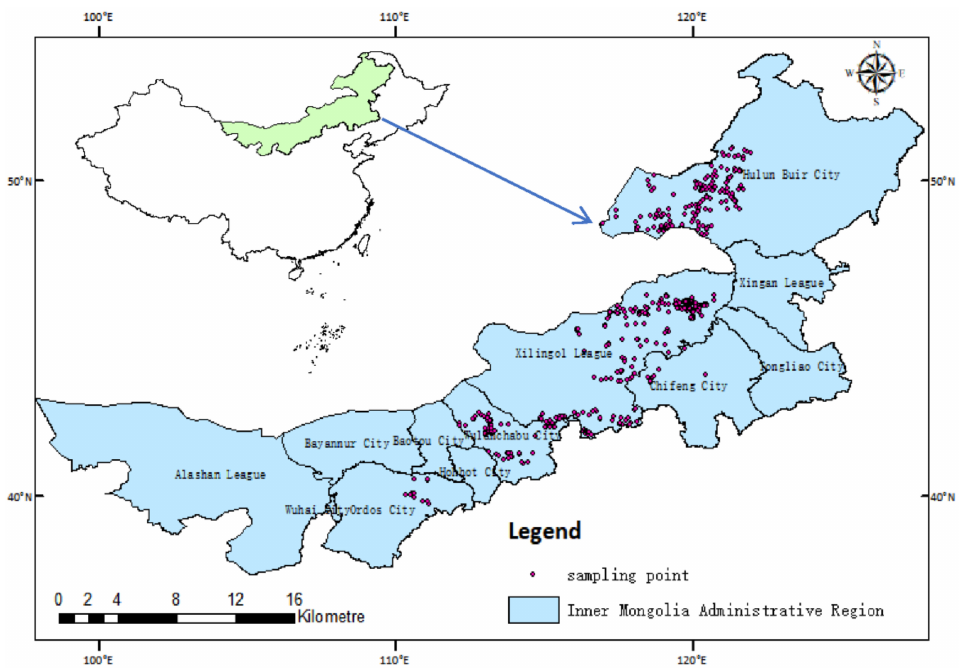
Figure 1. The survey data points for the dominant locust species in Inner